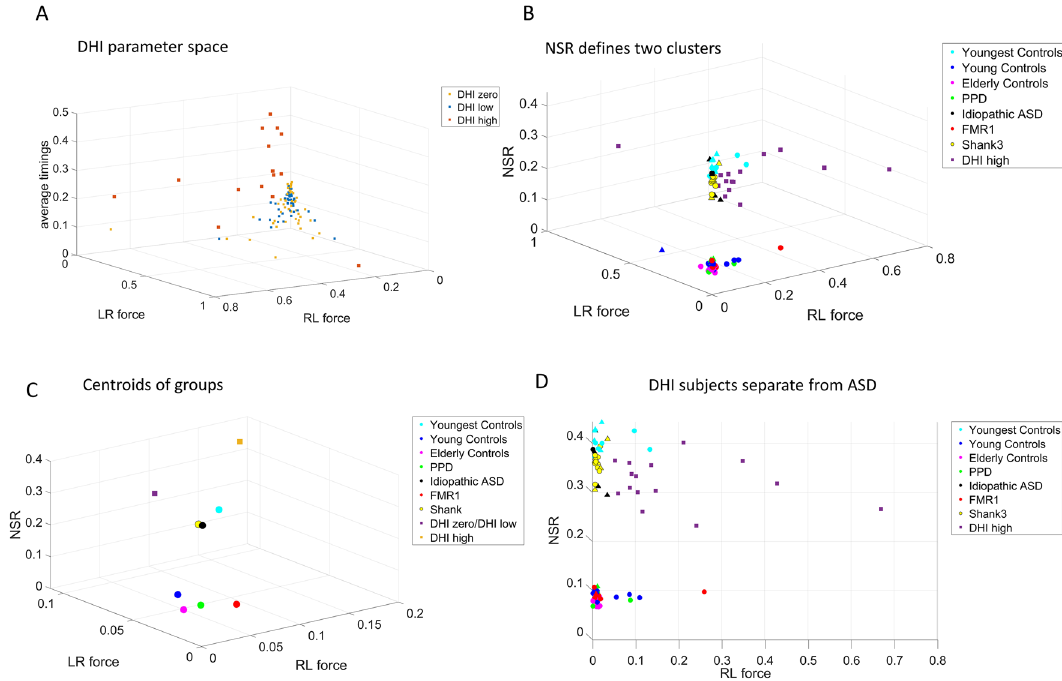
Figure 8. Vestibular DHI vs. subcortical PPD and FMR1 automatically segregate and point at gait differences in idiopathic- and SHANK3-ASD. ( A ) Severe vestibular DHI scores above 16 are clinically significant and separate from low-to-mild cases in the parameter space of average timings, left-to-right, right-to-left feet acceleration MMS forces (causality divided by corresponding lags) ( B ). High vestibular DHI, idiopathic ASD, SHANK3-ASD participants and their youngest age- and sex-matching controls separate along both the NSR and the force axes, from the older controls, the PPD and the FRM1 carriers. In non-DHI participants, circular markers represent females and triangular markers represent males. Two sample t tests showed no significant differences between males and females. ( p values across x–y–z dimensions for the upper cluster ; . 25, .94, .83 > .05, p values across x–y-z dimensions for the lower cluster; .26, .12, .06 > .05). ( C ) The averaged point (centroid) of each group emphasizes the separation in ( B ). ( D ) A 2-D projection of the 3-D plot of ( B ) with all DHI included, shows